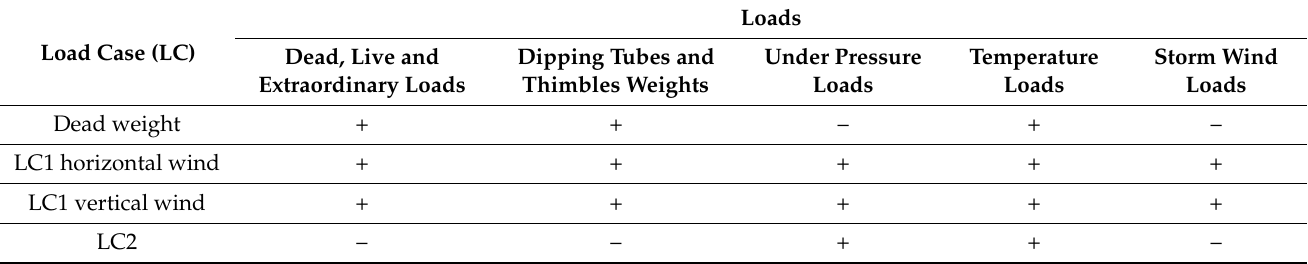
Table 1. External forces included in the FEM (Finite Element Method) analysis—mineral materials processing installation.